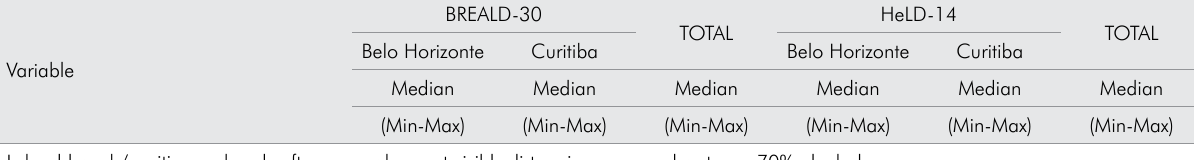
Table 2. Associations between level of OHL measured by BREALD-30 and HeLD-14 and care conceptions related to COVID-19 in the cities of Belo Horizonte and Curitiba,